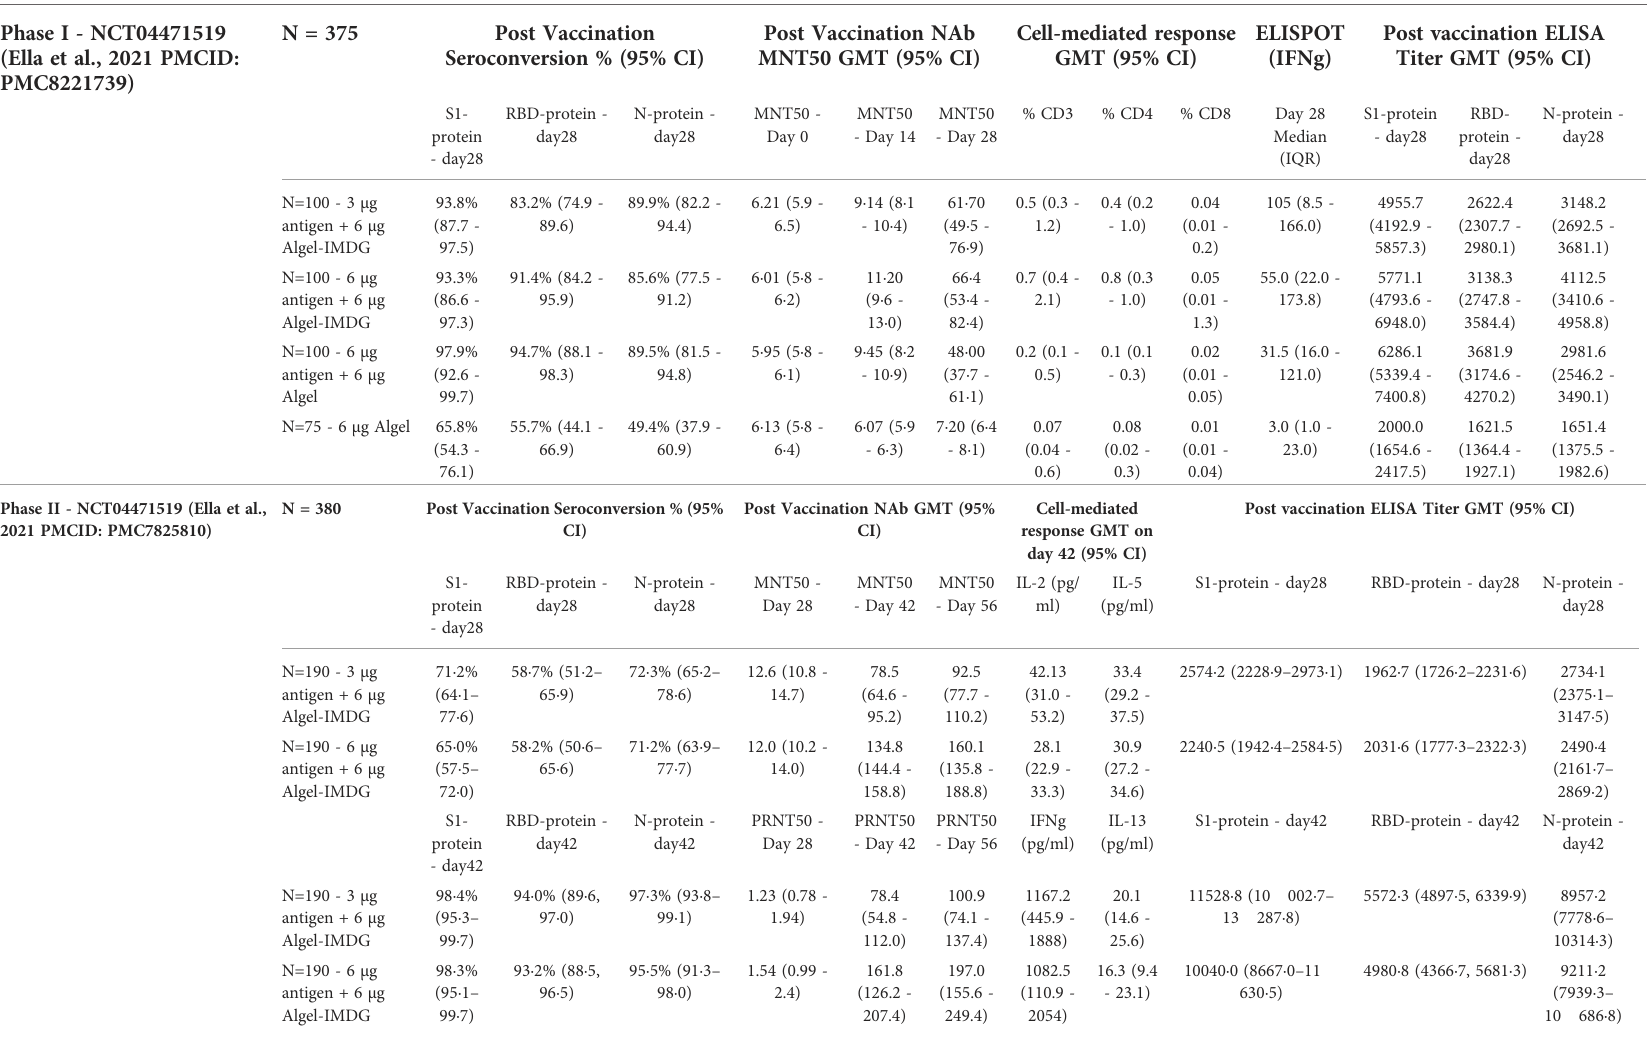
TABLE 2 BBV152 Phase I, II and III